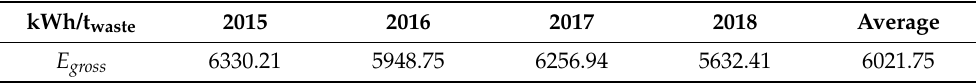
Table 6. Gross energy.